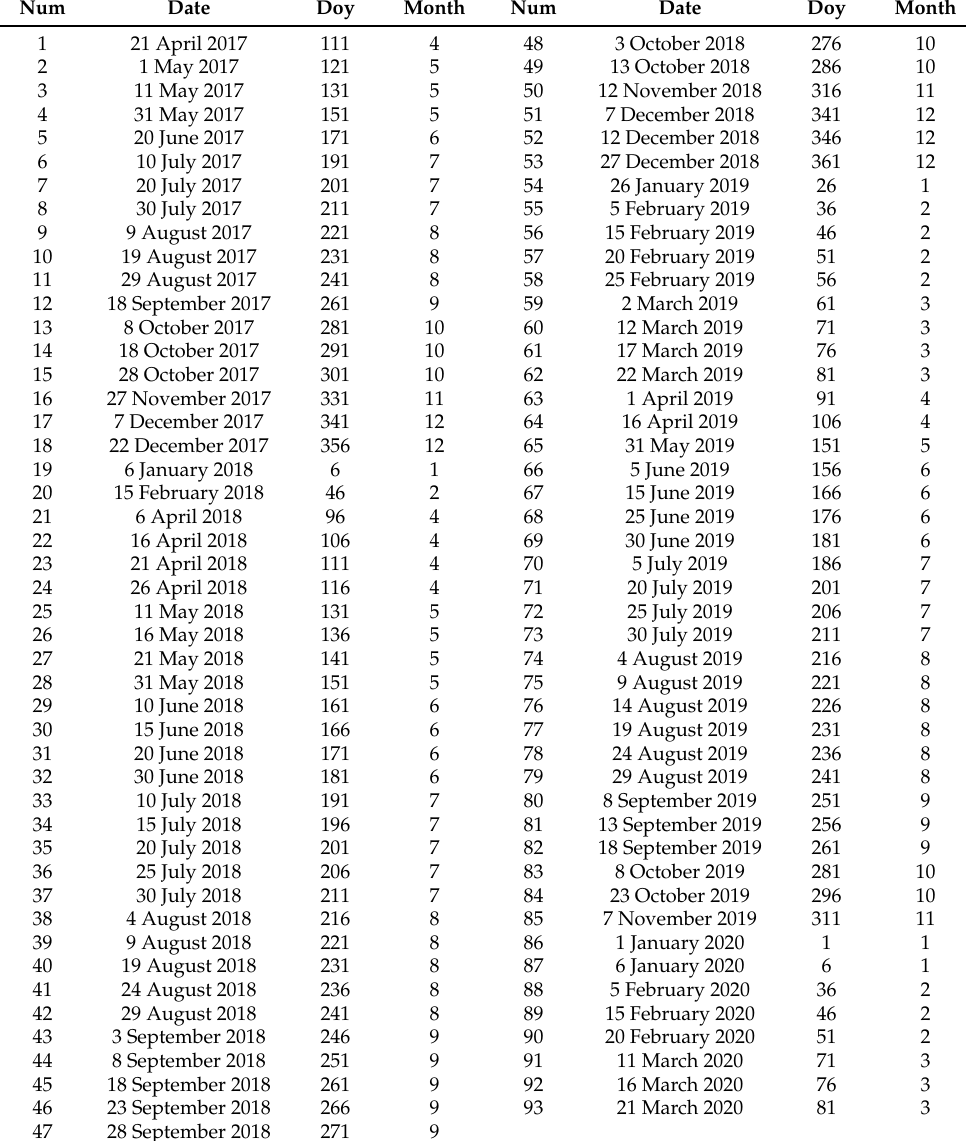
Table A3. List of Sentinel-2 images selected for this